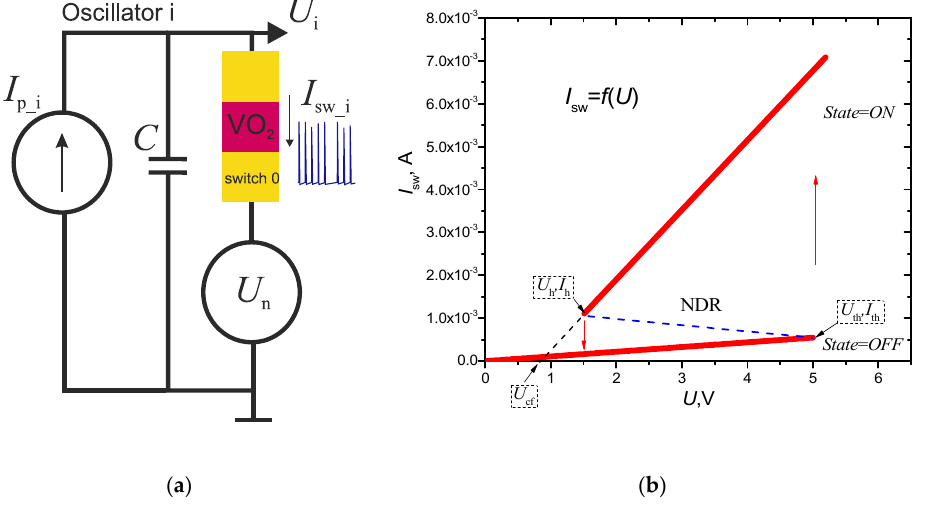
Figure 7. ( a ) Diagram of a single oscillator based on a VO 2 structure. Note: I = number of the oscillator; I p = current source; C = capacitance; U n = noise source; I sw = current passing through the VO 2 switch; U = voltage on the switch. ( b ) Model I-V characteristic of a separate switch.